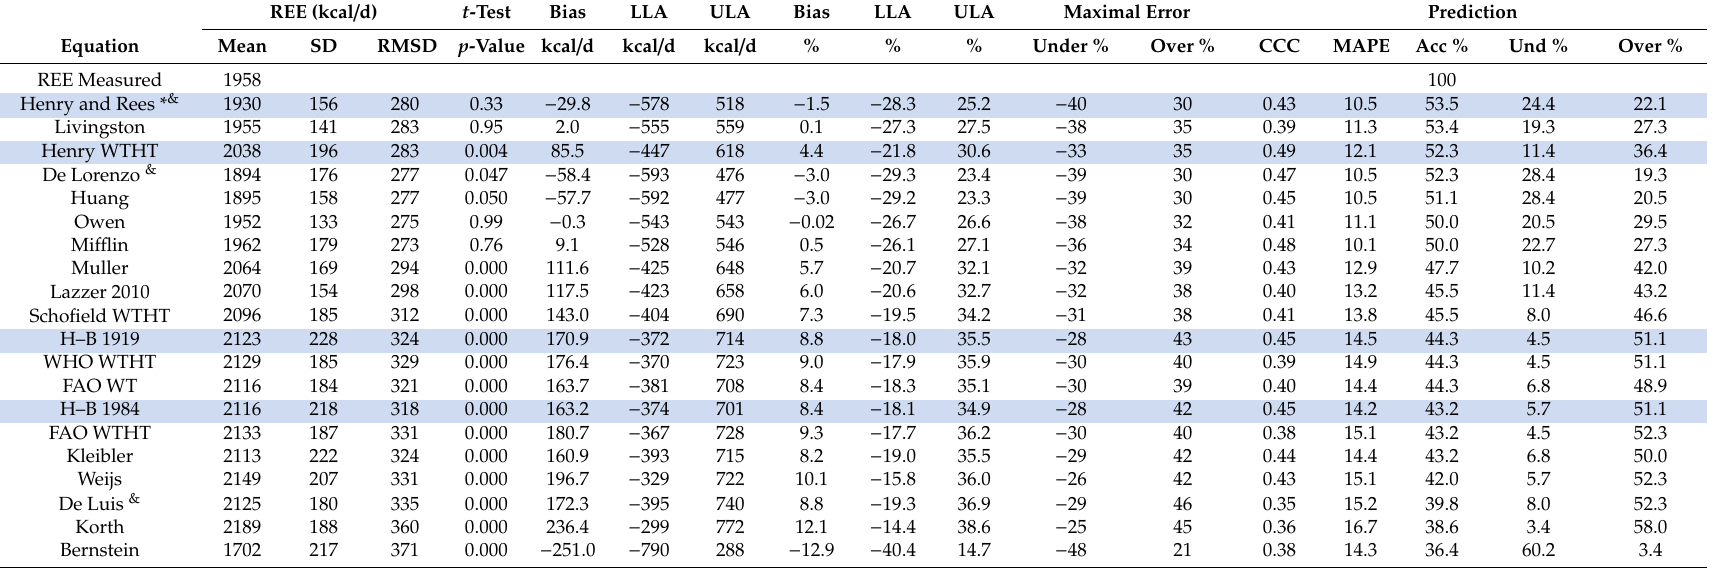
Table 4. Assessment of resting energy prediction equations in overweight and obese men ( n = 88) from the population of Gran